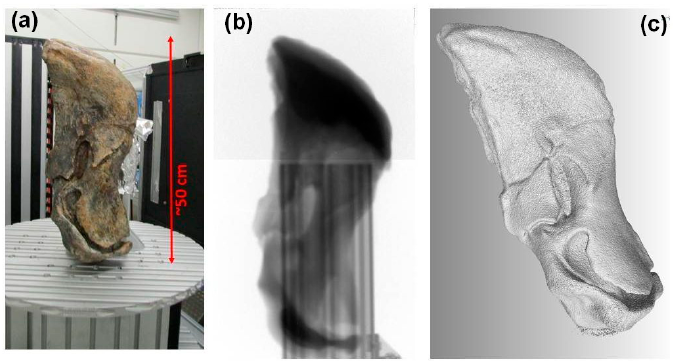
Figure 9. Tomography studies of the lower jaw of Stahleckeria potens with a length of about 50 cm (Paleontological Collection of Universität Tübingen, number GPIT/RE/7106-2, examined at the NECTAR facility; ( a ) a photograph of the sample positioned at the sample stage; ( b ) a single projection (stitched two normalized radiographs); ( c ) 3D visualization of the reconstructed object (original pictures).